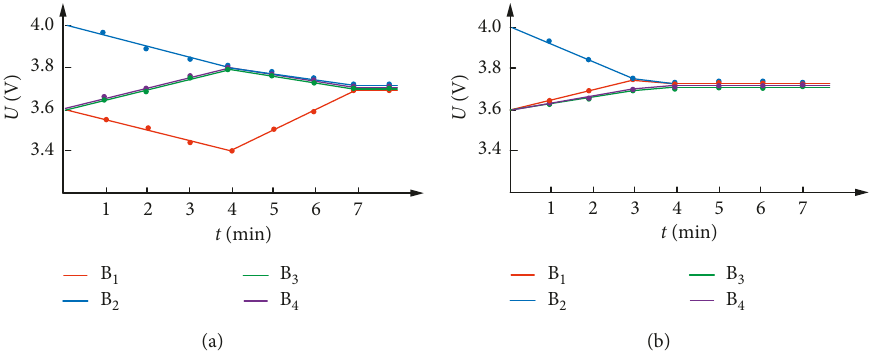
Figure 11: Equalization time for experiments: (a) traditional control and (b) HNFABC.